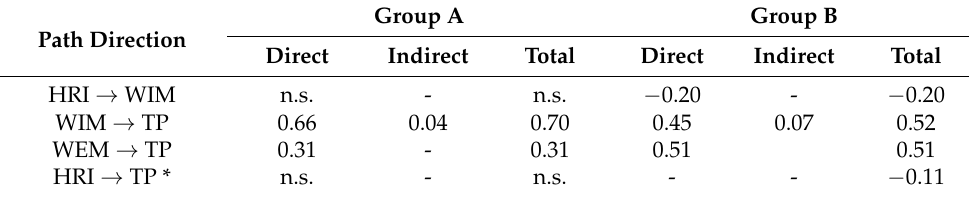
Table 6. The summary of direct, indirect, and total effects of path. Path Direction